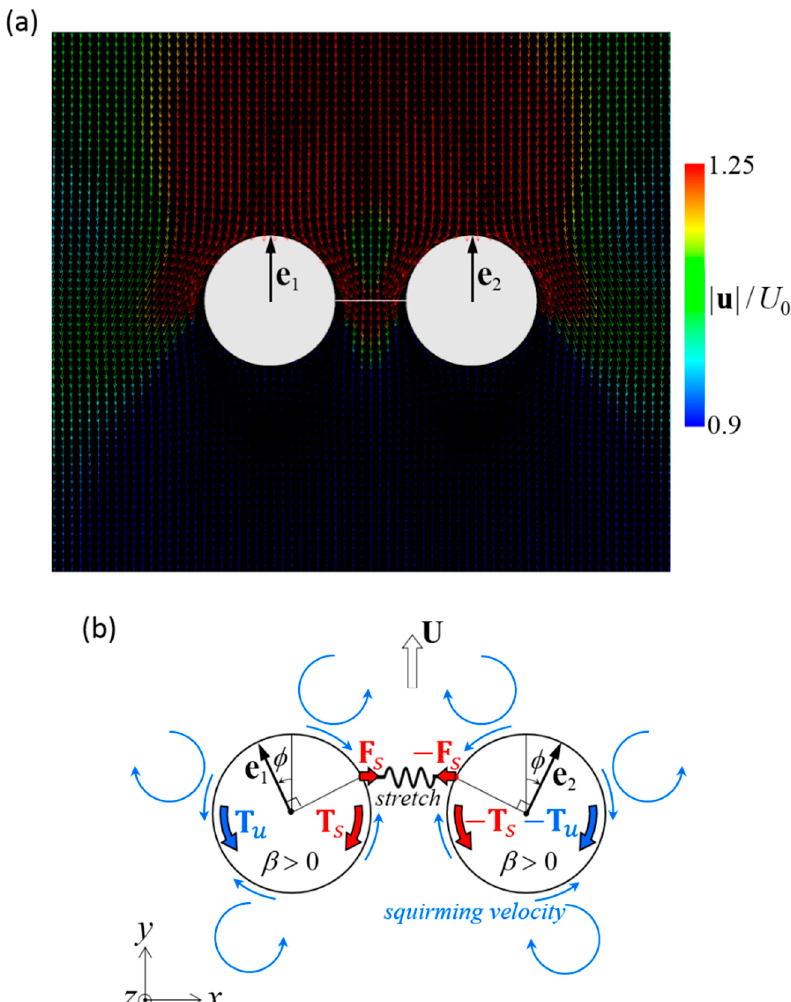
Figure 8. Mechanism of stable swimming of dumbbell squirmers connected side-by-side. ( a ) Velocity field around a stable dumbbell squirmer with β = 3. ( b ) Schematics of the torque balance. Two squirmers tended to move away from each other, and the spring was stretched. The spring force F s induced spring torque T s to the squirmer (red arrows). The squirming velocity (blue arrows), generated hydrodynamic torque T u . The configuration became stable when the two torques canceled each other out.